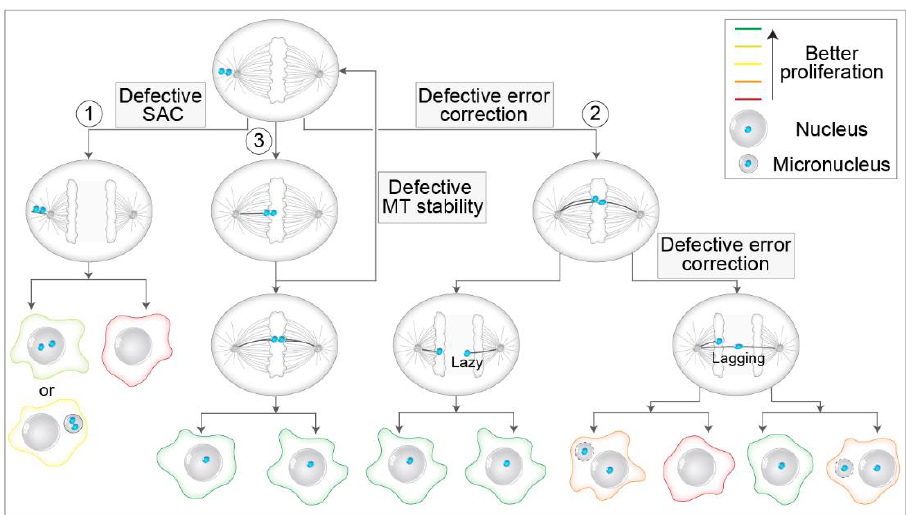
Figure 7. Routes to chromosome mis-segregation through unaligned polar chromosomes and their consequences. A process flow diagram depicting different pathways of the pseudo-metaphase cell with an unaligned polar kinetochore pair and their consequences: (1) mis-segregation of the unaligned chromosome by precocious anaphase start, (2) alignment to the metaphase plate (white area) with the merotelic attachment, which can be (left path) either resolved by error correction and result only in lazy kinetochore with appropriate attachment or (right path) left unresolved resulting in the persistent lagging chromosome with merotelic attachment, and (3) alignment of the polar kinetochore to the metaphase plate which can result in either successful biorientation (bottom path) or return of the kinetochore pair back to the pole and the initial position due to the defective stability of kinetochore microtubules (right path). The arrows signify the changes in time. Multiple arrows starting from one cell signify the opposite result of a process. Red to green lines on the cell borders represent the level of detrimental effects on the proliferative capacity of daughter cells (legend on the top right). Large grey spheres depict nuclei, and small grey spheres micronuclei (legend on the top right). Micronuclear membrane instability is depicted by dashed